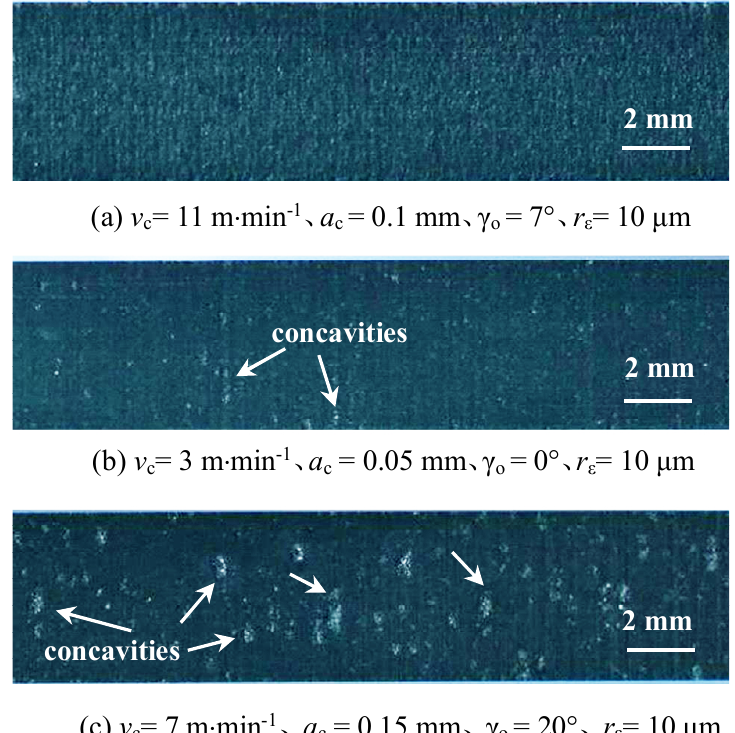
Figure 7. Machined surface profile at different cutting parameters.